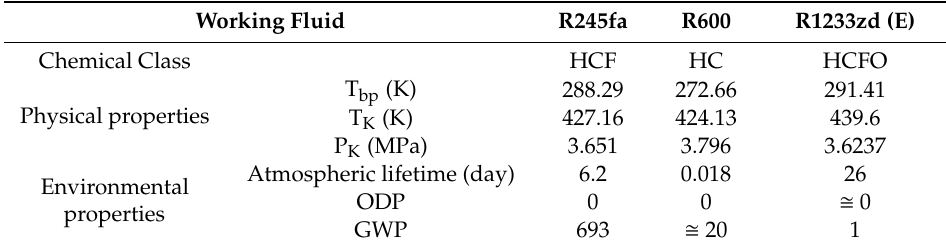
Table 2. Properties of applied working fluids. Source: Own study based on